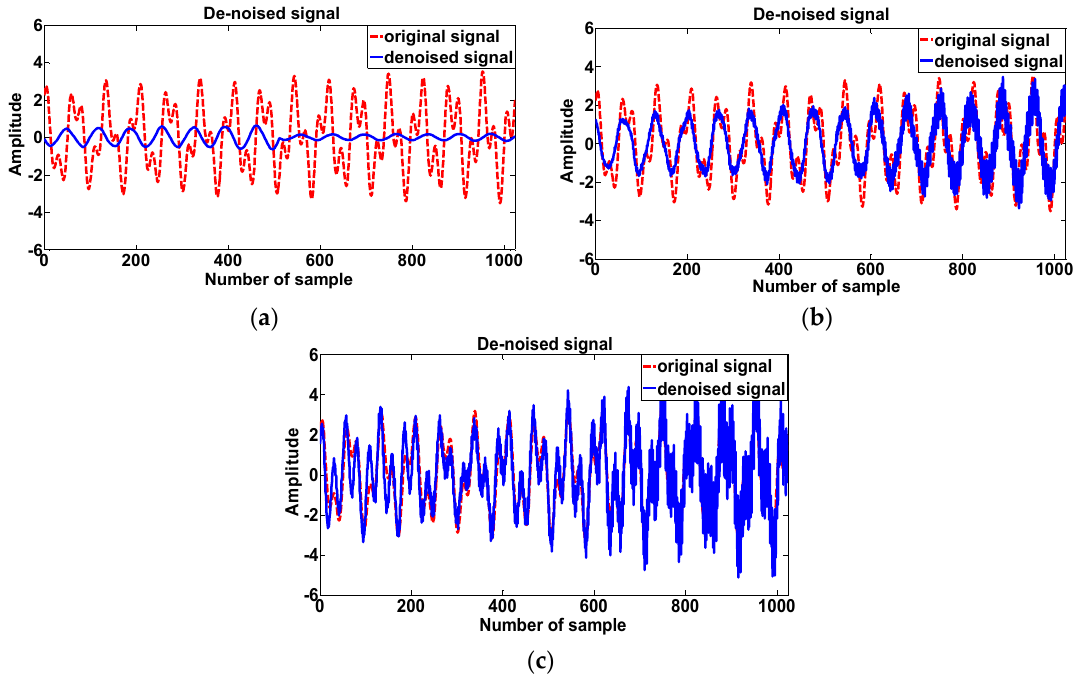
Figure 4. Contrasting figure of de ‐ noised effect about three different methods on the time ‐ domain waveform with initial signal ‐ to ‐ noise ratio (SNR) is − 11.21 db. The time ‐ domain waveform of the de ‐ noised signal (blue curve) based on four methods should be compared with the pure signal (red curve). ( a ) De ‐ noised signal based on MPODSOISE, MPOCSOISE; ( b ) De ‐ noised signal based on MMBDSOISE; ( c ) De ‐ noised signal based on MMBCSOISE.